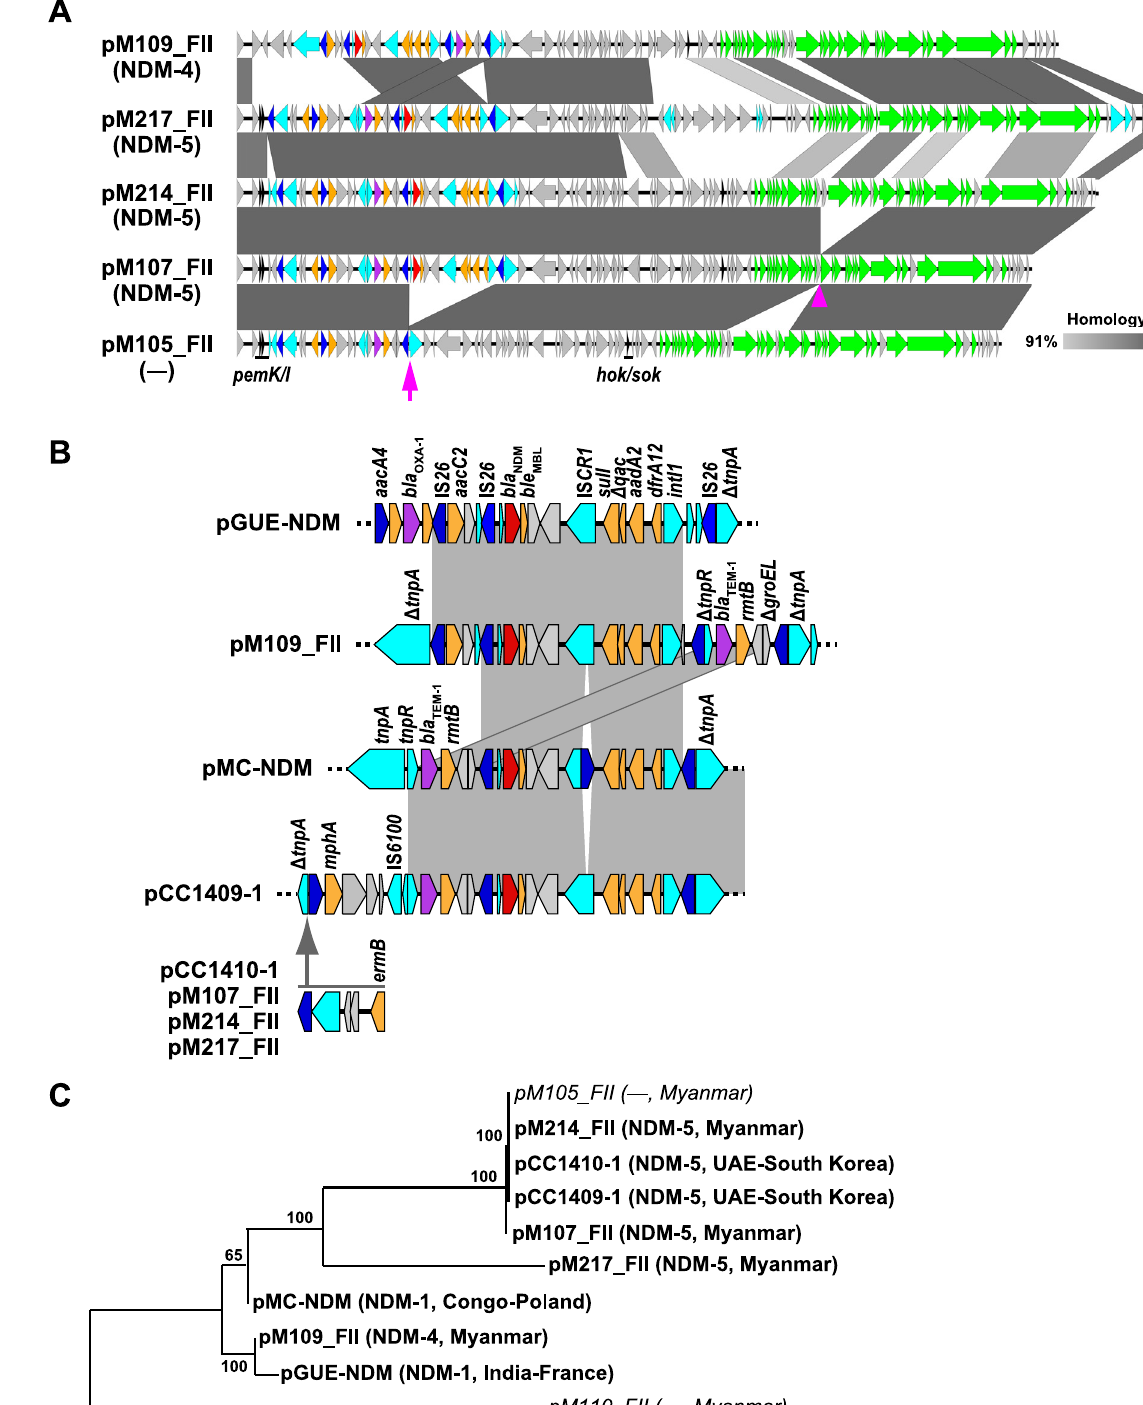
PLOS ONE | https://doi.org/10.1371/journal.pone.0184720 September 14,